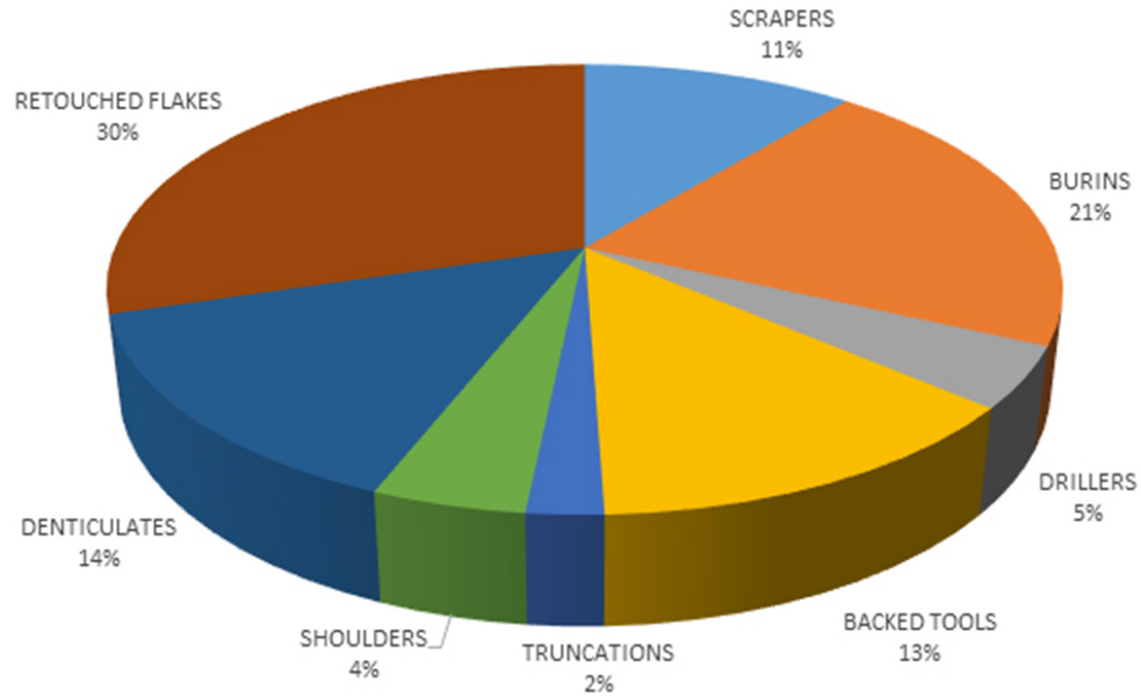
Figure 6. Total retouched material from the assemblage.